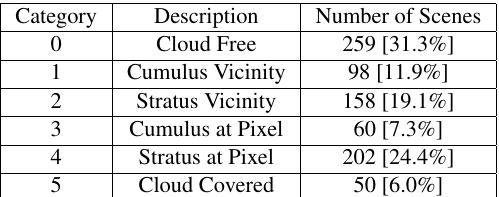
Table 1: Categories used in cloud analysis and breakdown of the number of scenes in each category for the Landsat 5 validation dataset.